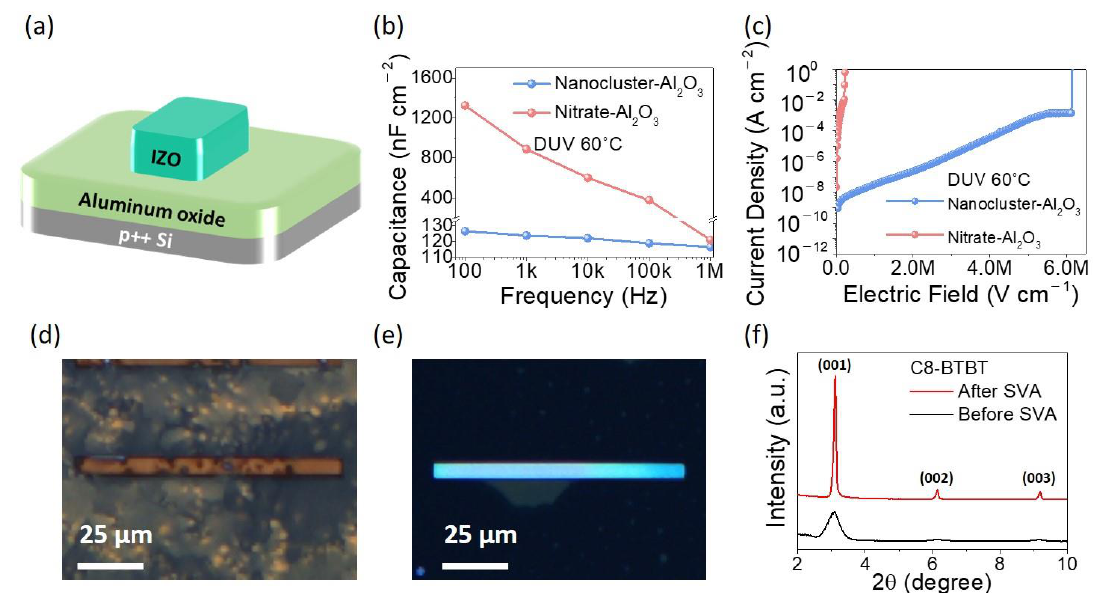
Figure 3. ( a ) Schematic illustration of IZO / Al2O3 / p ++ Si capacitor structure. ( b ) Leakage current density as a function of the electric field (J-E) and ( c ) capacitance–frequency (C-F) characteristics of nanocluster- and nitrate-based Al 2 O 3 gate dielectrics. cross-polarized optical microscopy (CPOM) images of ( d ) polycrystalline C8-BTBT film spun on patterned polymethylmethacrylate (PMMA) layer and ( e ) 100 µ m long C8-BTBT microrod-shaped single crystal preferably located at the pristine PMMA region after solvent vapor annealing (SVA) for 15 h. ( f ) XRD spectra of the as-spun film (before SVA) and microrod single-crystal arrays (after SVA) of